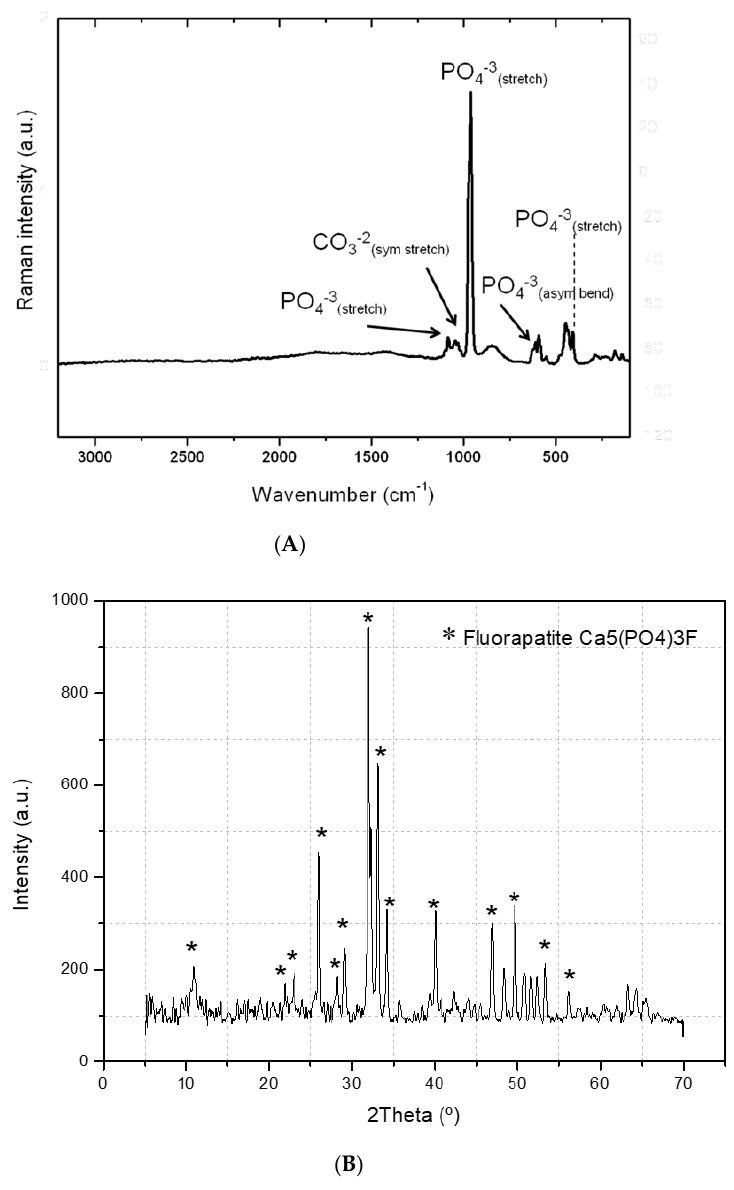
Figure 1. (Fourier-transform)FT-Raman spectra ( A ) and X-ray diffractogram pattern ( B ) of calcium phosphate derived from shark tooth ( P. glauca and I. oxyrinchus